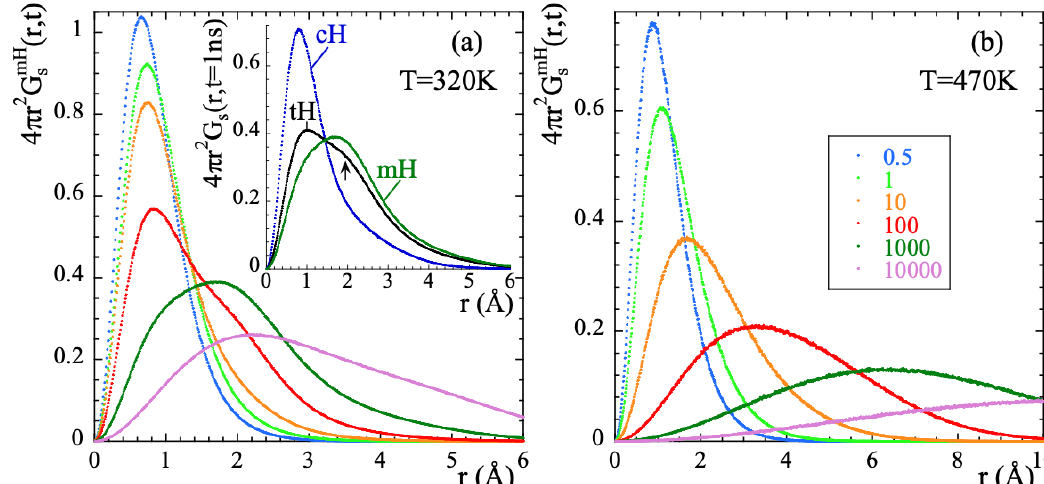
Figure 6. Radial probability distribution function calculated for methyl-group hydrogens at 320 K ( a ) and 470 K ( b ) at the different times (in ps) indicated in ( b ). For t = 1000 ps, the insert in ( a ) compares this function for methyl-group hydrogens, main-chain hydrogens and total hydrogens. The arrow marks the location of a second peak (hump) in the function corresponding to tHs (see the text).